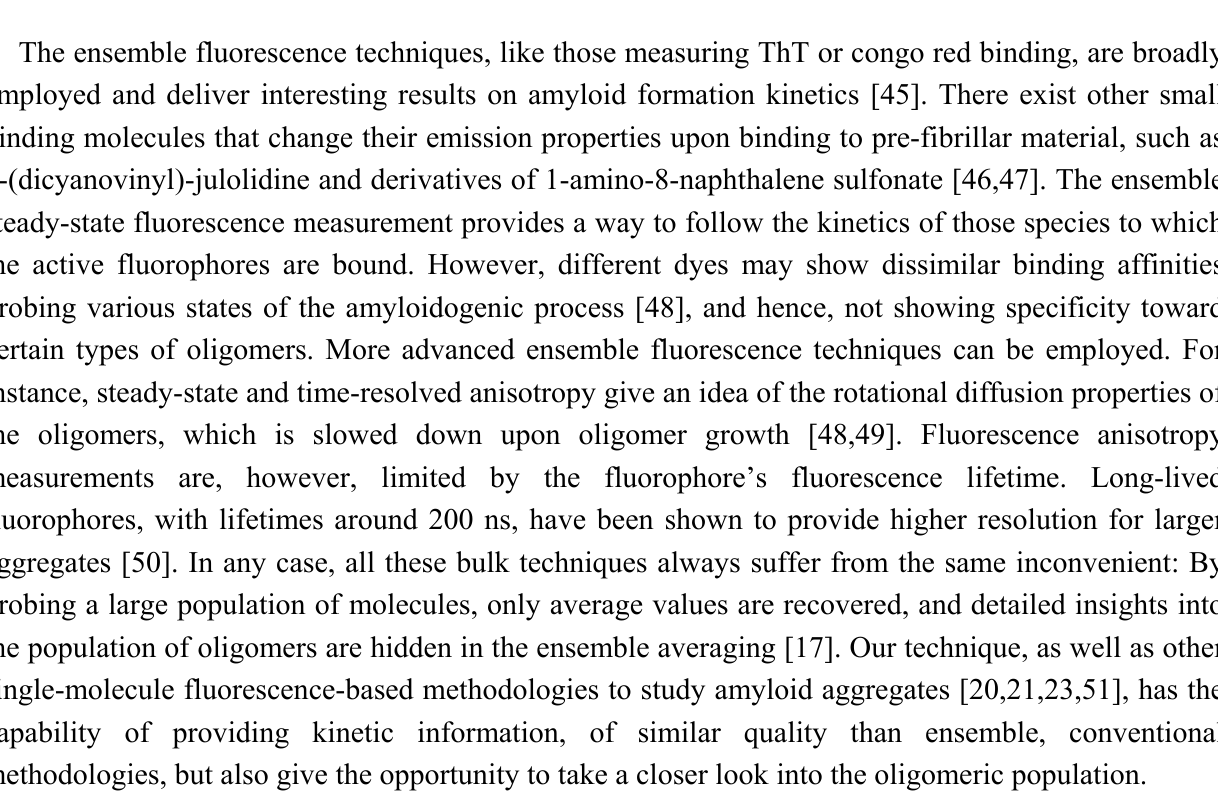
Figure 5. ( A ) Concentration of labeled monomers obtained from the fitted lifetime-weighted autocorrelation functions. The line represents exponential decay fits. ( B ) Single-molecule fluorescence bursts, corrected using the different dilution factors from the AF488 (black) and AF647 (red) channels. ( C ) Average single-molecule fluorescence bursts, corrected by the different dilution factors, (black symbols) fitted to a double exponential decay function (blue line). The figure also presents the corresponding Thioflavin T (ThT) fluorescence emission trace (red line) of an unlabeled sample incubated under the same experimental conditions. ( D ) Transmission electron micrographs of the incubated samples after 0 h (left), 4 h (middle), and 48 h (right) of incubation. Scale bars represent 200